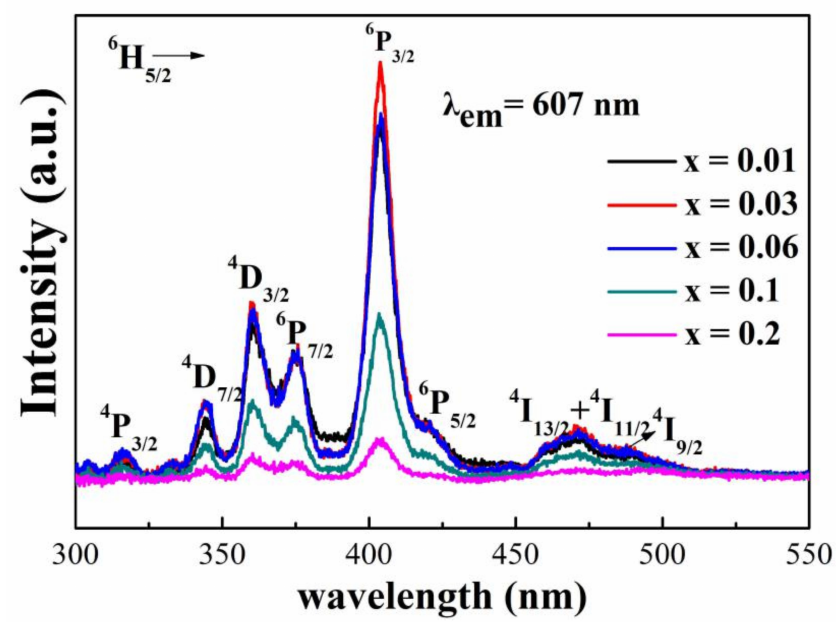
Figure 6. Photoluminescence excitation spectra of Al 2 O 3 -(3-x)SrO: xSm 3+ (x = 0, 0.01, 0.03, 0.06, 0.1, 0.2) glasses under an excitation of 607